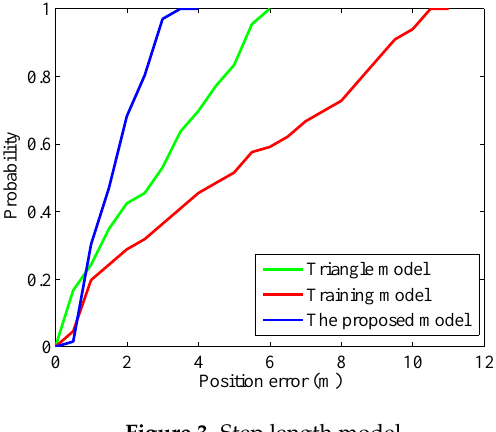
Figure 3. Step length